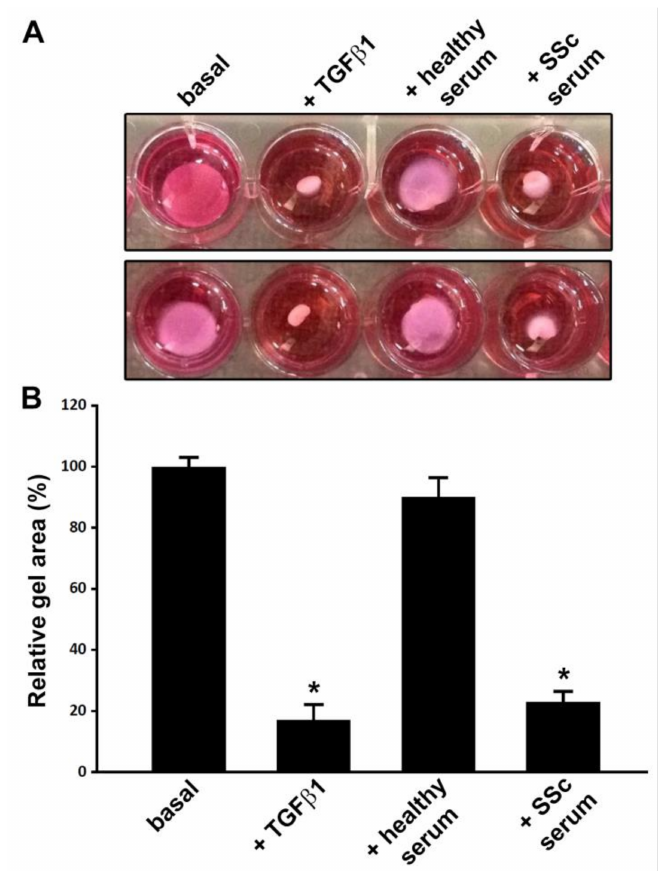
Figure 4. Normal human adipose-derived stem cells (ADSC) treated with serum from systemic sclerosis (SSc) patients acquire the ability to e ff ectively contract collagen gel. ( A ) Representative images of collagen gel contraction assay with ADSC at basal conditions and after treatment with recombinant human transforming growth factor- β 1 (TGF β 1; 10 ng / mL), 10% serum from healthy individuals ( n = 6) or 10% serum from patients with early di ff use cutaneous SSc ( n = 6) for 96 h. Results are representative of three independent experiments performed with three ADSC lines. ( B ) Gel area expressed as percentage of that observed in basal ADSC. Data are mean ± SEM. Statistical analysis was carried out with Student’s t -test. * p < 0.001 vs. basal and healthy